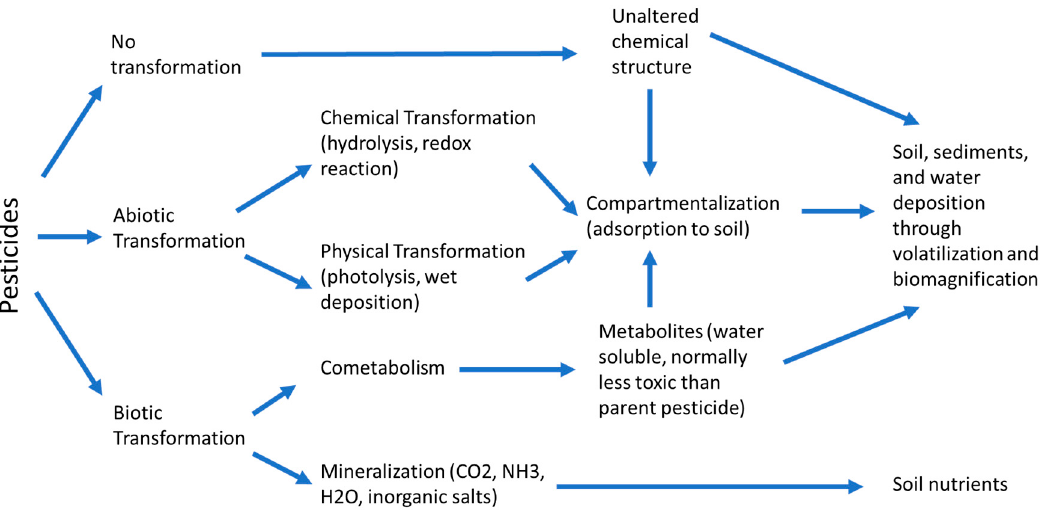
Figure 1. Fate of pesticide.